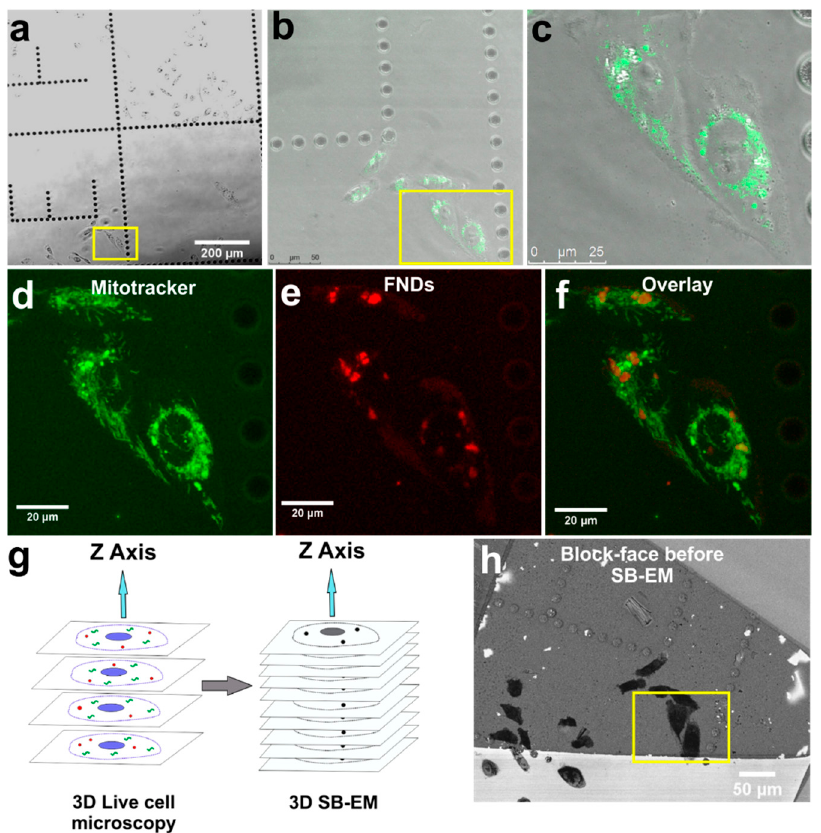
Figure 1. The 3D correlative light and electron microscopy workflow demonstrating the live-cell confocal microscopy to the serial block-face scanning electron microscopy (SB-EM). ( a ) Bright-field image of the living cells on a gridded glass-bottom dish. The cells selected for 3D CLEM are indicated by the yellow box. ( b ) MitoTracker signal from the stained selected cells (indicated by the yellow box). ( c ) Close-up view of the selected cells shown by an overlay of brightfield and MitoTracker images. ( d ) Maximum intensity z-projection image from the MitoTracker channel of the selected cells. ( e ) Maximum intensity z-projection image from the fluorescent nanodiamond (FND) channel of the selected cells. ( f ) Overlay of maximum intensity z-projections of MitoTracker and FND channels. ( g ) Schematic representation of 3D CLEM workflow with FNDs (red dots) and a standard organic fluorophore (green structures). ( h ) Localization of the selected cells on the EM block-face (near the letter E) for SB-EM. The yellow box indicates the same selected cells as in ( a ). Tracker (green) and the FND (red) signals (Figure 1d–f and Video S1). MitoTracker signal